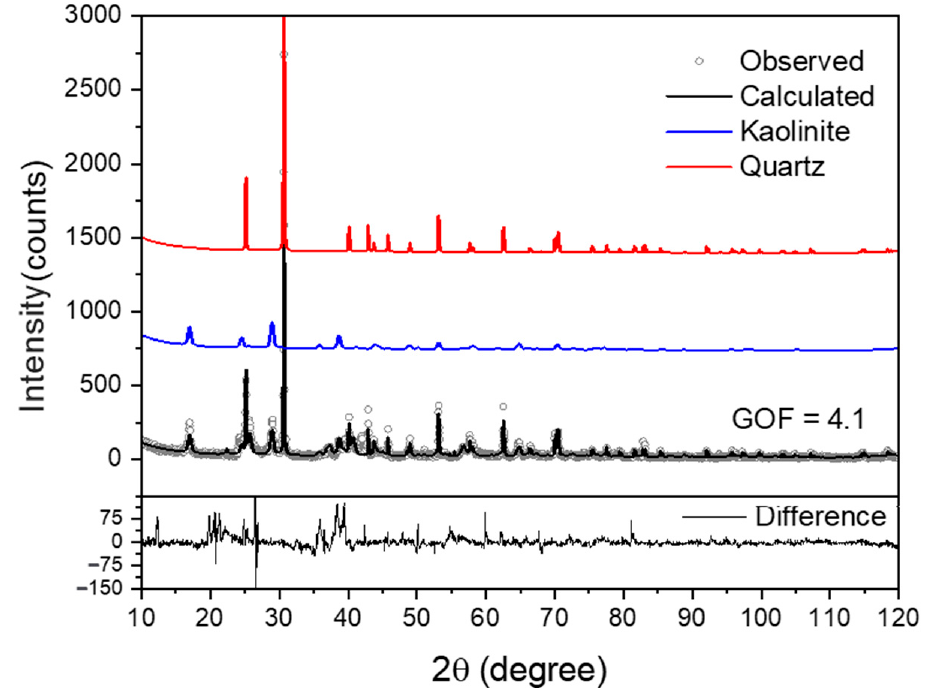
Figure 2. Rietveld refinement of unheated F2 sample. The simulated diffraction patterns of quartz and kaolinite are shown in red and blue, respectively. The crystallographic identification file from ICDD reference code used for both phases are 00-046.1045 for quartz (SiO 2 —hexagonal P3221) and 00-029-1488 for kaolinite (Al 2 Si 2 O 5 (OH) 4 —monoclinic C12m1). The concentrations of phases were quartz 44%, kaolinite 33% and hematite, goethite and gibbsite the remainder. In the fired samples, goethite and gibbsite were not detected in samples heated at temperatures greater than 250 ◦ C. This occurs due to the loss of –OH in the dehydration process [23–25]. Another transformation observed after 530 ◦ C was the dehydration of kaolinite [26,27]. The kaolinite mineral was not detected in samples heated at temperatures greater than 530 ◦ C. The dehydration reaction can be described as [23]: